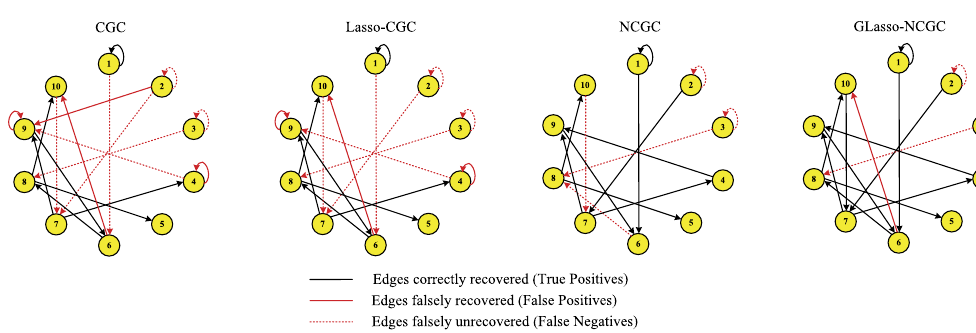
Figure 2. Networks inferred by CGC, Lasso-CGC, NCGC, GLasso-NCGC in nonlinear VAR